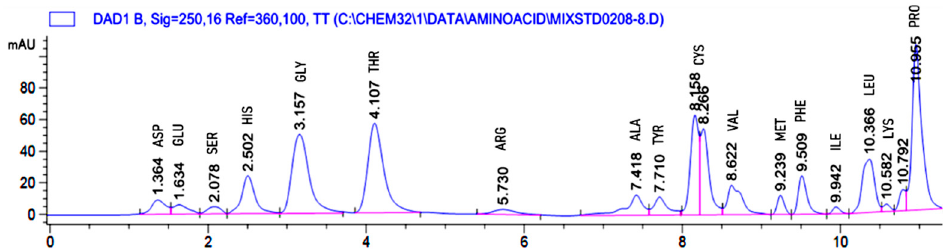
Figure 5. High-performance liquid chromatography (HPLC) chromatogram of chicken feather degradation lysate by Bacillus sp. strain UPMAGG-1.